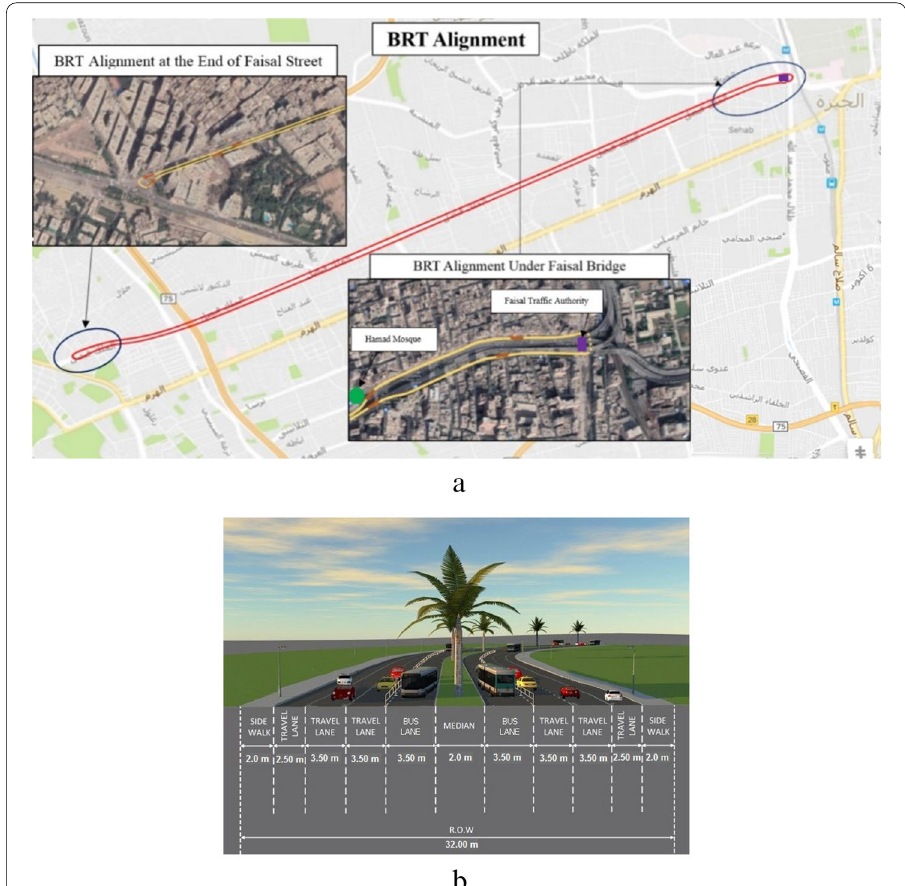
Fig. 3. Proposed BRT system configuration. a Proposed BRT alignment. b Proposed cross-section for Faisal